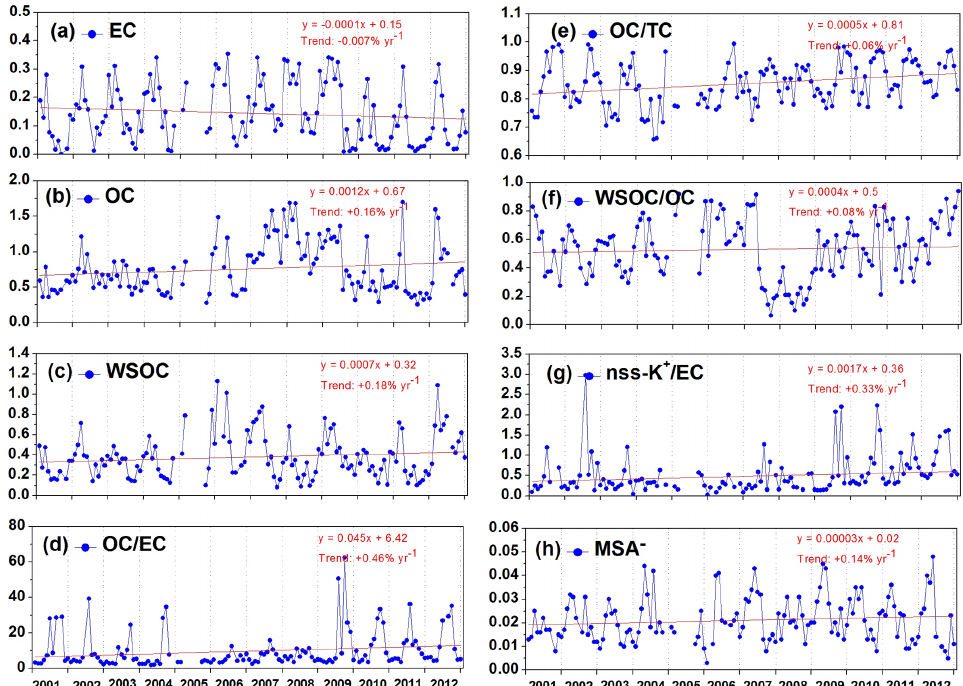
Figure 5. Annual trends (time series) in the concentrations (µgm − 3 ) of carbonaceous aerosol components, water-soluble ionic tracer com- pound (MSA − ) and some specific mass ratios during 2001–2012 over the western North Pacific. The linear trend equation ( y = mx + c ) is also shown for the each annual